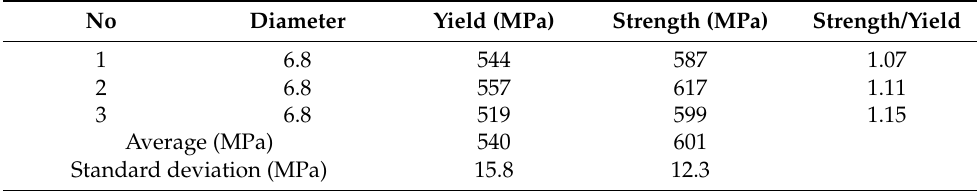
Table 7. Tension test results of rods.